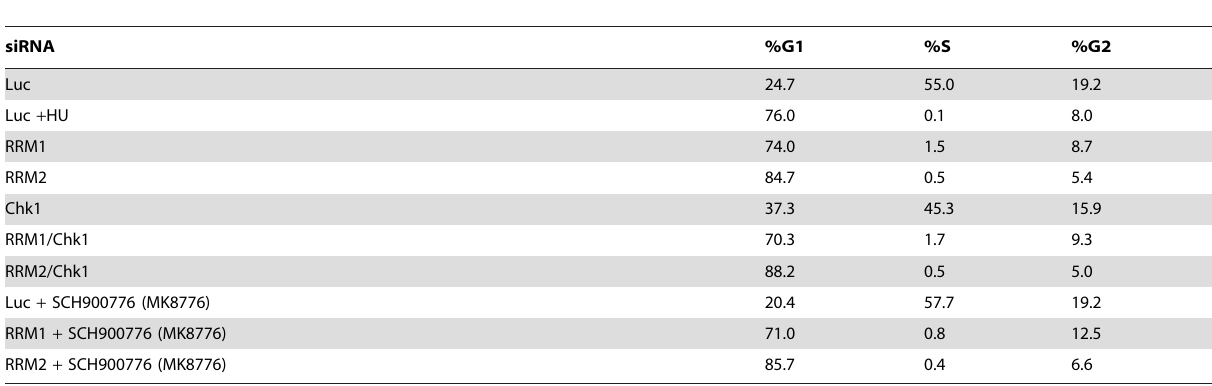
Table 2. Percentage of cells in G1, S, or G2 phase.